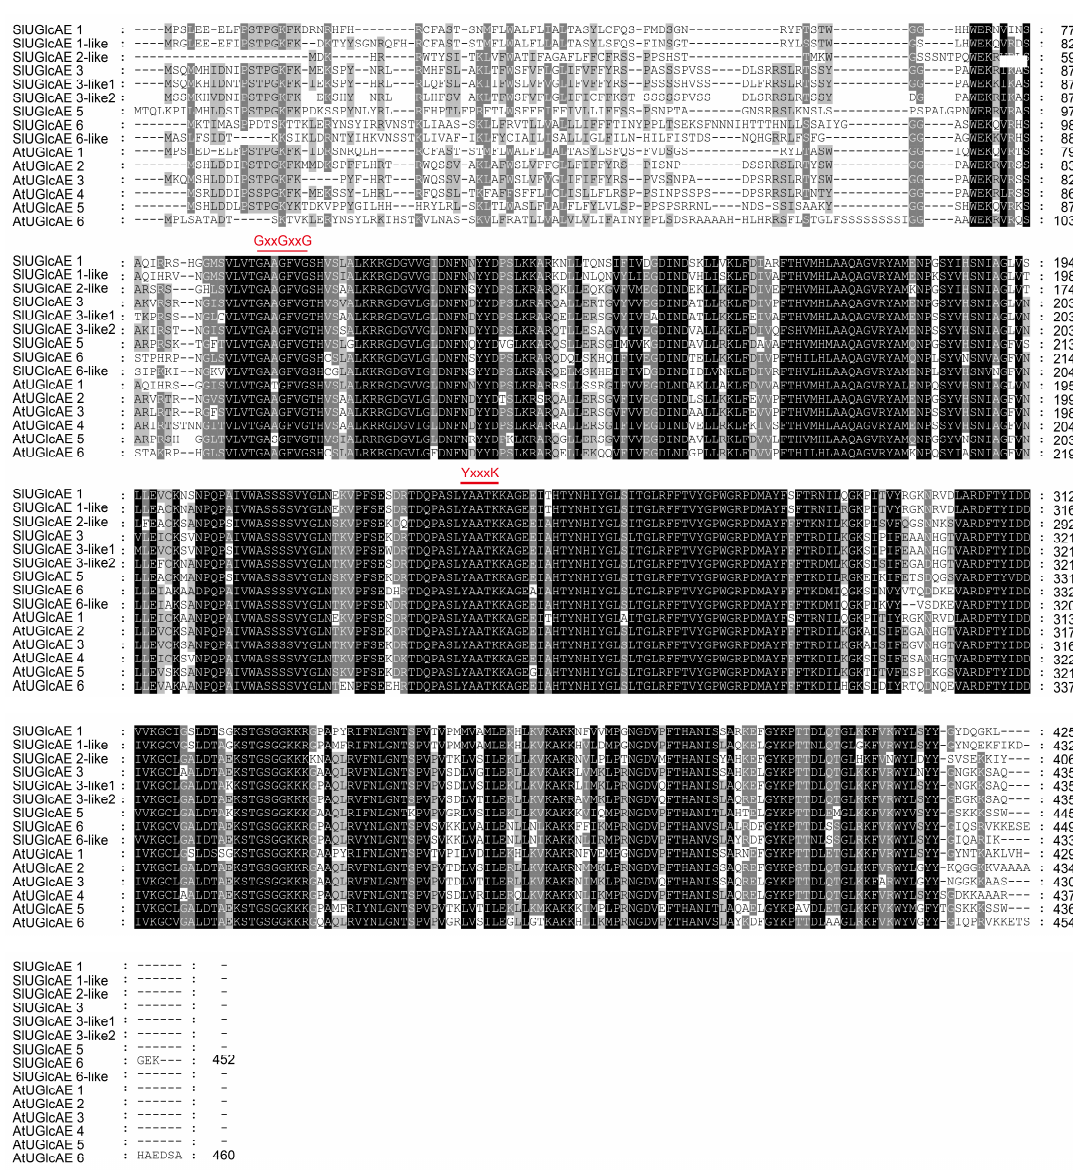
Figure 4. Amino acid sequence alignment of SlUGlcAE in tomato and AtUGlcAE in Arabidopsis thaliana . The black backgrounds indicate the strictly conserved residues, and the gray backgrounds indicate the similar amino acid residues. The GxxGxxG and YxxxK motifs are marked above the sequence alignment in red.